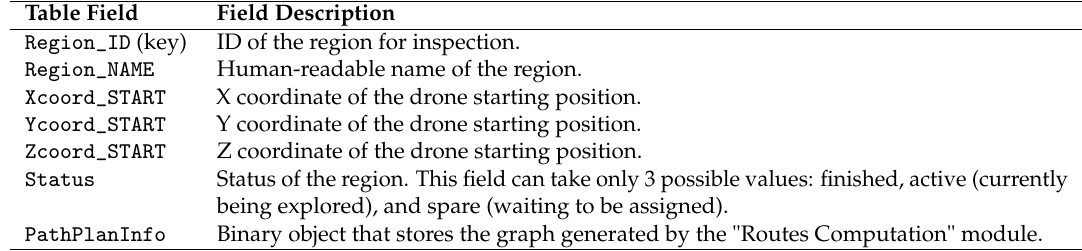
Table 2. Definition of the table “Regions”. Field Description